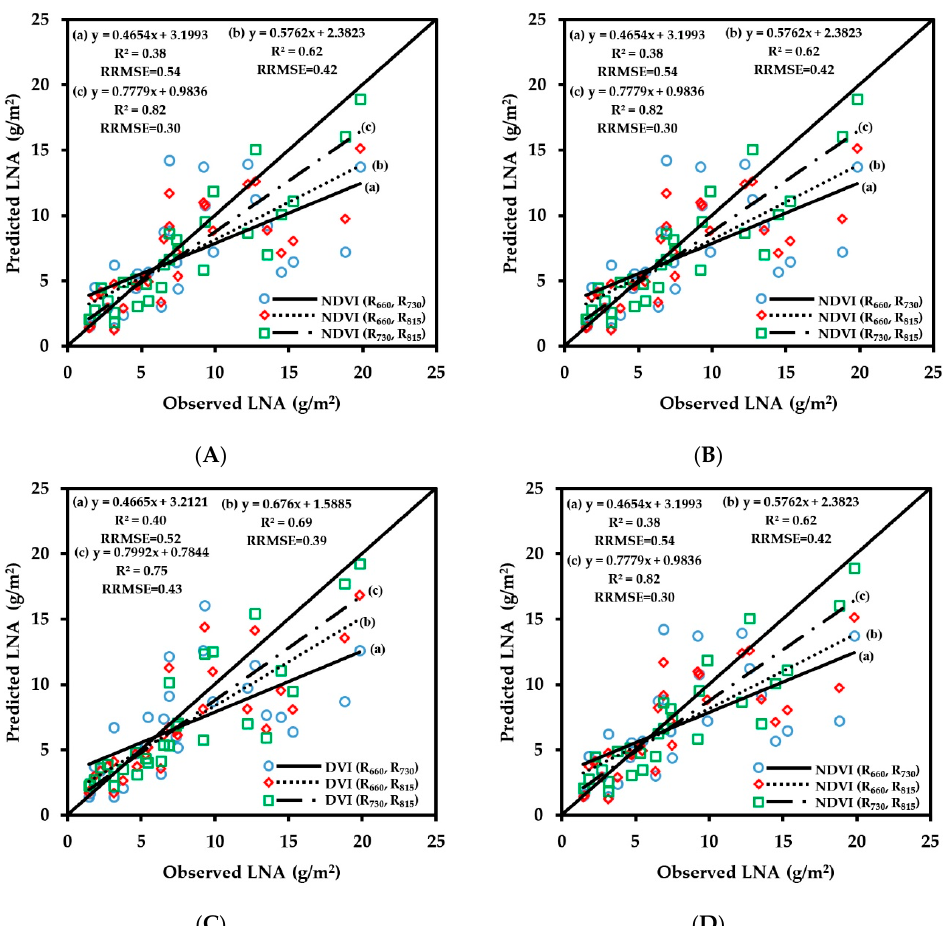
Figure 13. The relationships between observed and predicted LNA values of wheat varieties based on NDVI ( A ), RVI ( B ), DVI ( C ) and TVI ( D )